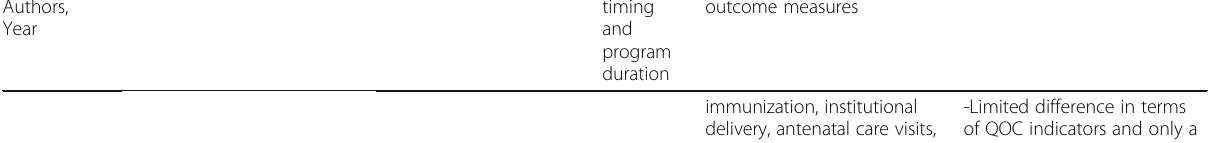
Table 1 Description of RBF evaluation reports including evaluation methods and key findings, by country (Continued) Country,